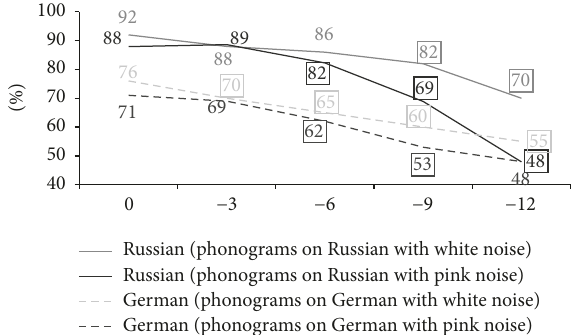
Figure 2: Recognition of the utterance language: comparison of Russian and German in noisy environment (with various types of noise and various levels of signal-to-noise ratio).